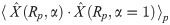
Emergence of structure in the energy landscape at low covariance strength.All states in the light dataset with five or more spike counts were sorted by spike count and grouped into 100 equally populated groups. Averages were calculated over the states within each group (for clarity here indexed by p); the color of the line indicates the average spike count within a group (1613 states per group). A. Average similarity in direction of sampling between full model and model at correlation strength α. This is estimated as the average over data states, p, within a given group of states: 〈X^(Rp,α)·X^(Rp,α=1)〉p. B. Similarities of magnitudes, estimated as 〈||X(Rp, α)|| / ||X(Rp, α = 1)||〉p. Dotted black lines on both panels indicate α* and unity.